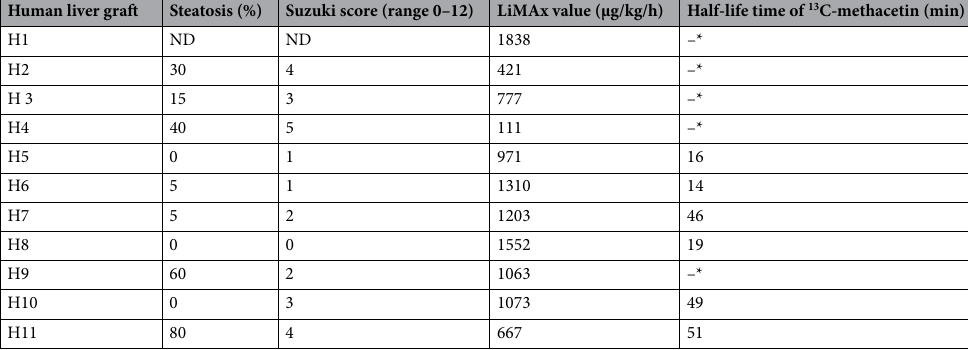
Table 2. Histology scores and metabolic evaluation. *Out of the 11 NMP procedures, in 5 cases the half-life time was not possible to calculated due to a small amount of data points after the DoB max